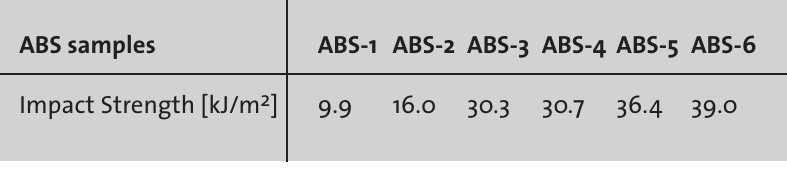
Figure 10: Correlation between the impact strength and M SAN for the studied ABS samples.